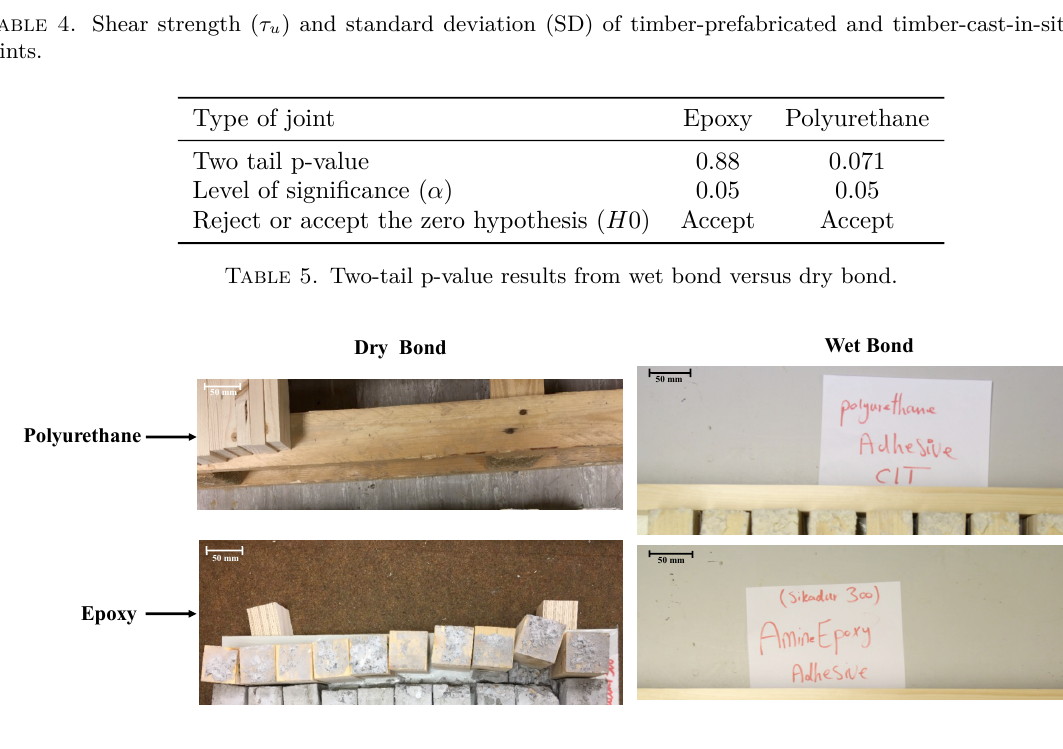
Figure 6. Fracture surfaces of timber-prefabricated concrete and timber-cast-in-situ concrete glued with polyurethane and epoxy